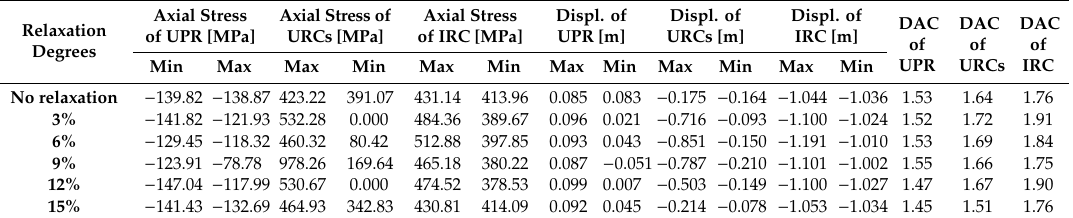
Table 3. Structural dynamic response under di ff erent cable relaxation